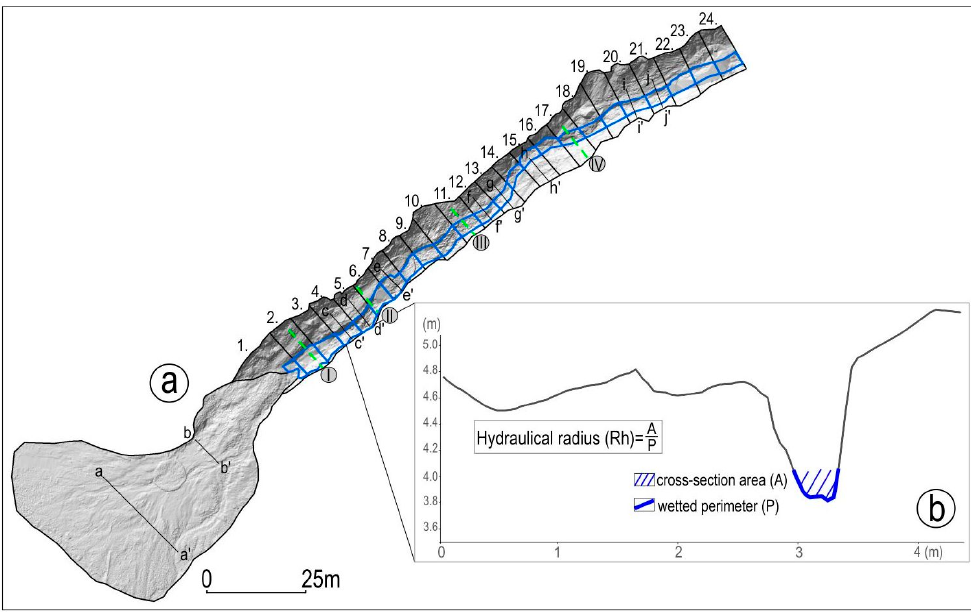
Figure 3. Segments (1–24) of the investigated road with the erosion gully marked by a blue line, cross-section profiles (I–IV) marked by dashed green, lines, and (a-j) marked by thin black lines ( a ). An example of the cross-section profile within one road segment (4) with the average level of water during a rainfall event marked ( b ).